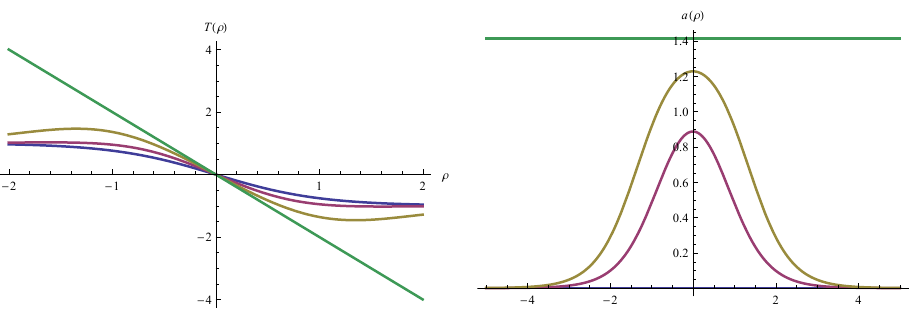
Figure 3 . The tension parameter T (left) and the boundary condition parameter a (right) as functions of ρ for fixed values of γ . The blue, red, yellow and green curves correspond to γ = 0 , √ √ √ 2 , γ = 0 . 99 / 2 and γ = 1 / 2 , respectively. We set φ γ = 0 . 9 /